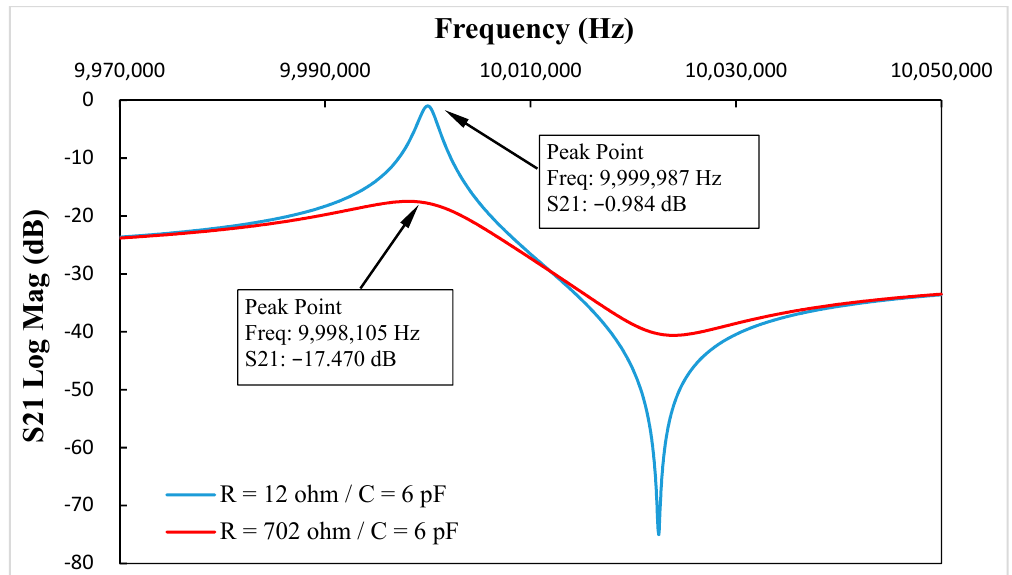
Figure 4. When C ∗ = 6.0 pF, the S21 parameters vs. frequency curve with and without added motional resistance.